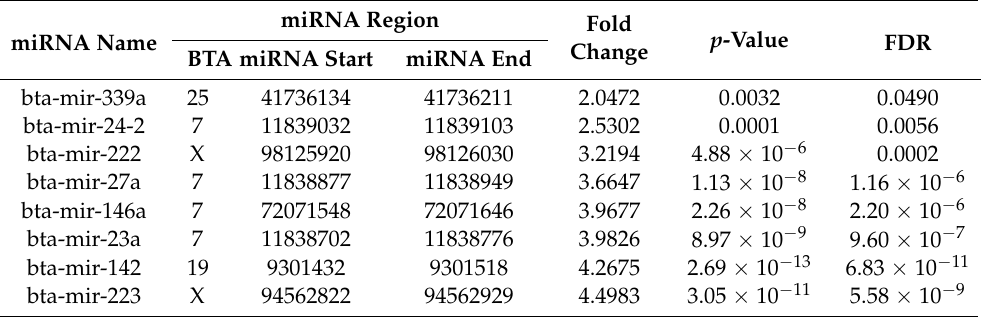
Table 2. Information about differentially expressed miRNAs between the mastitis and healthy samples in dairy cattle based on